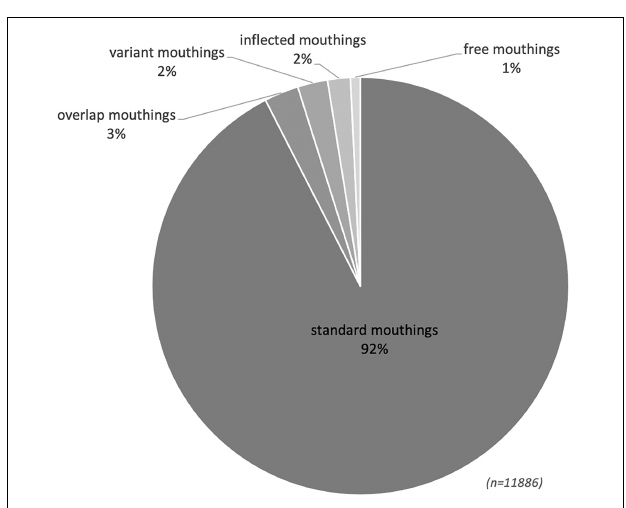
FIGURE 3 | Types of RSL